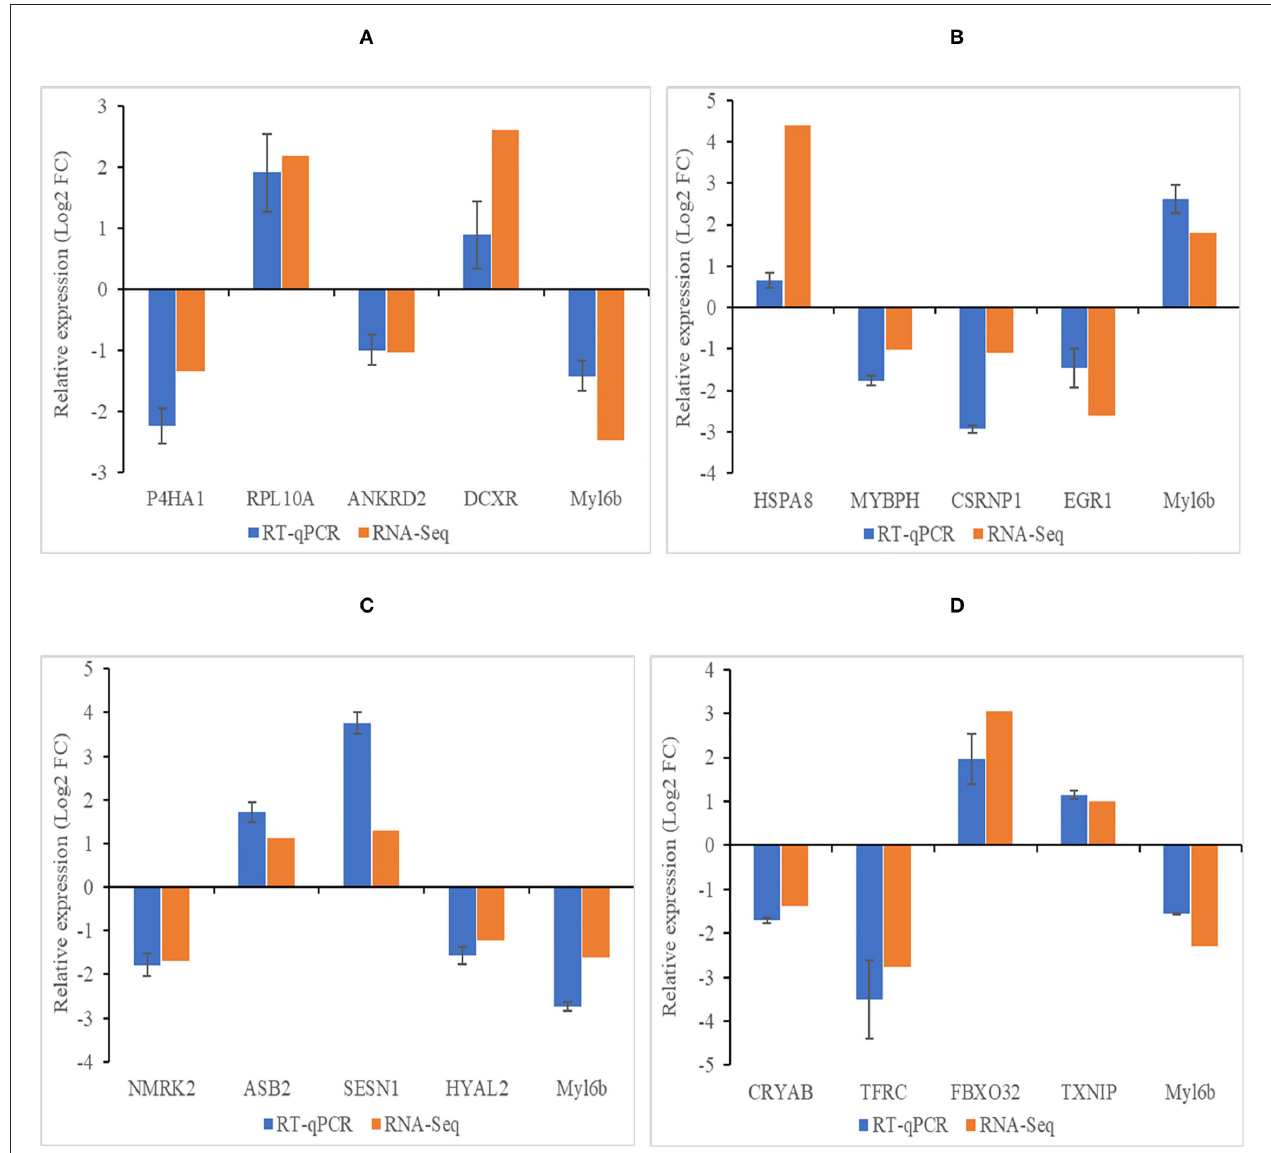
FIGURE 6 | Verification results of DEGs by RT-qPCR. (A–D) Histogram diagram of validation results in group of 4 months vs. 1.5 years, 1.5 years vs. 3.5 years, 3.5 years vs. 6 years, and 4 months vs. 6 years, respectively. Abscissa represents genes in different compare group, ordinate represents the relative fold change. Data shown on figure are mean ±